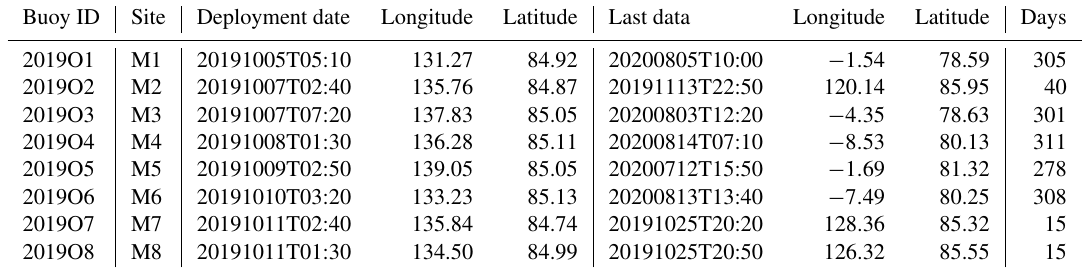
Table 1. Buoy deployment and recovery metadata. Buoy ID